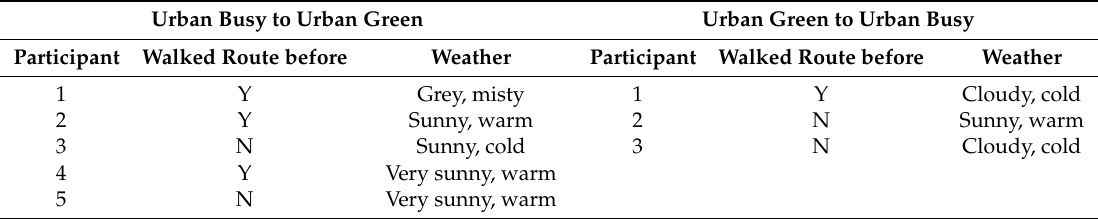
Table 1. Summary of weather conditions and participant familiarity with the study site. Urban Busy to Urban Green Urban Green to Urban Busy Participant Walked Route before Weather Participant Walked Route before